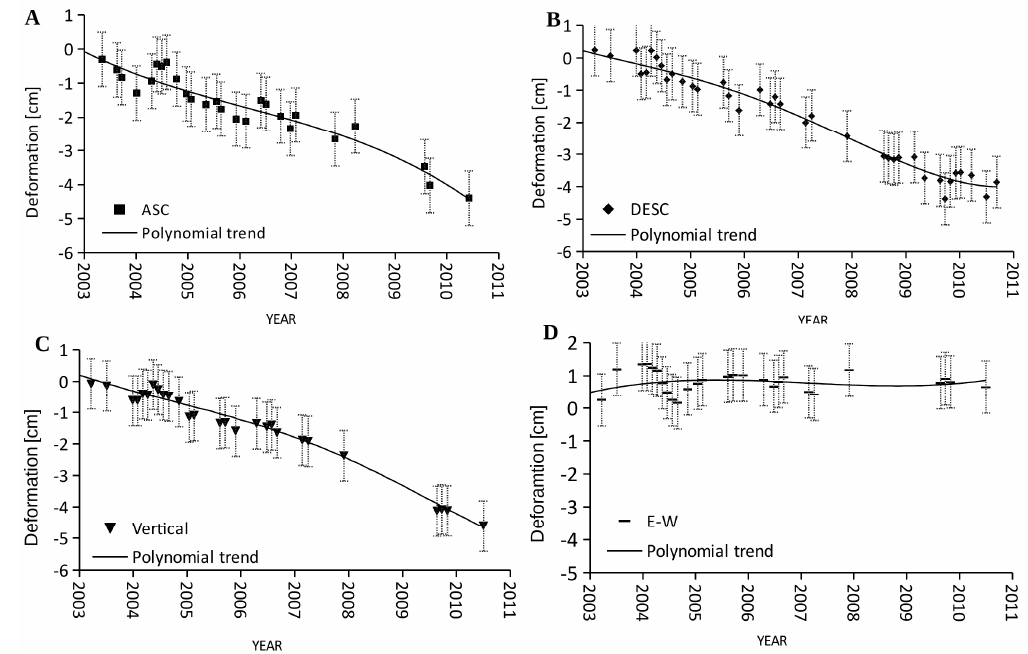
Figure 5. Average deformation time-series covering the December 2002–July 2010 time interval. ( A , B ) show LOS displacements measured during ascending and descending satellite passes, respectively; ( C , D ) show the computed vertical and (E-W) horizontal components of the displacements, respectively. Note that time-series have been obtained by averaging deformation time-series related to SAR measure points located within the detected subsidence area.